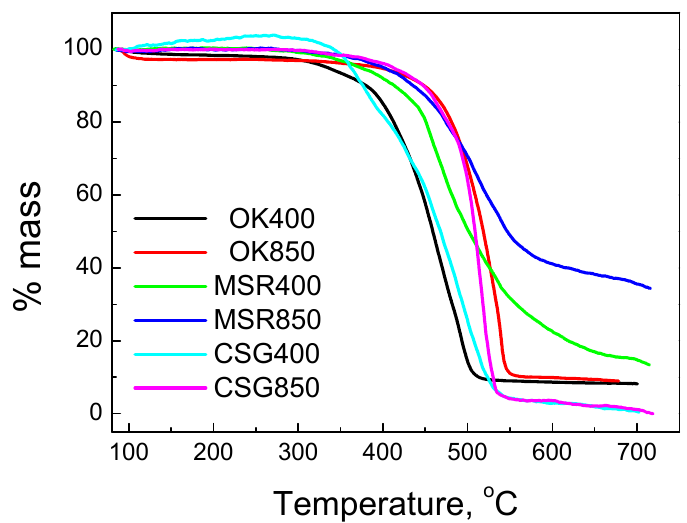
Figure 4. TGA curves under air atmosphere of the biochars studied.